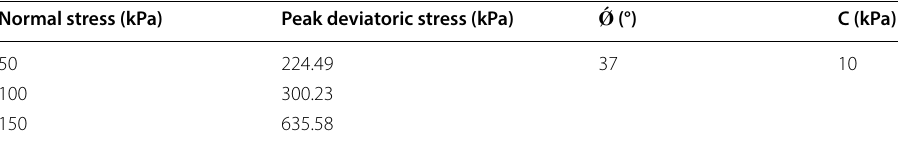
Table 3 Results of triaxial test Normal stress